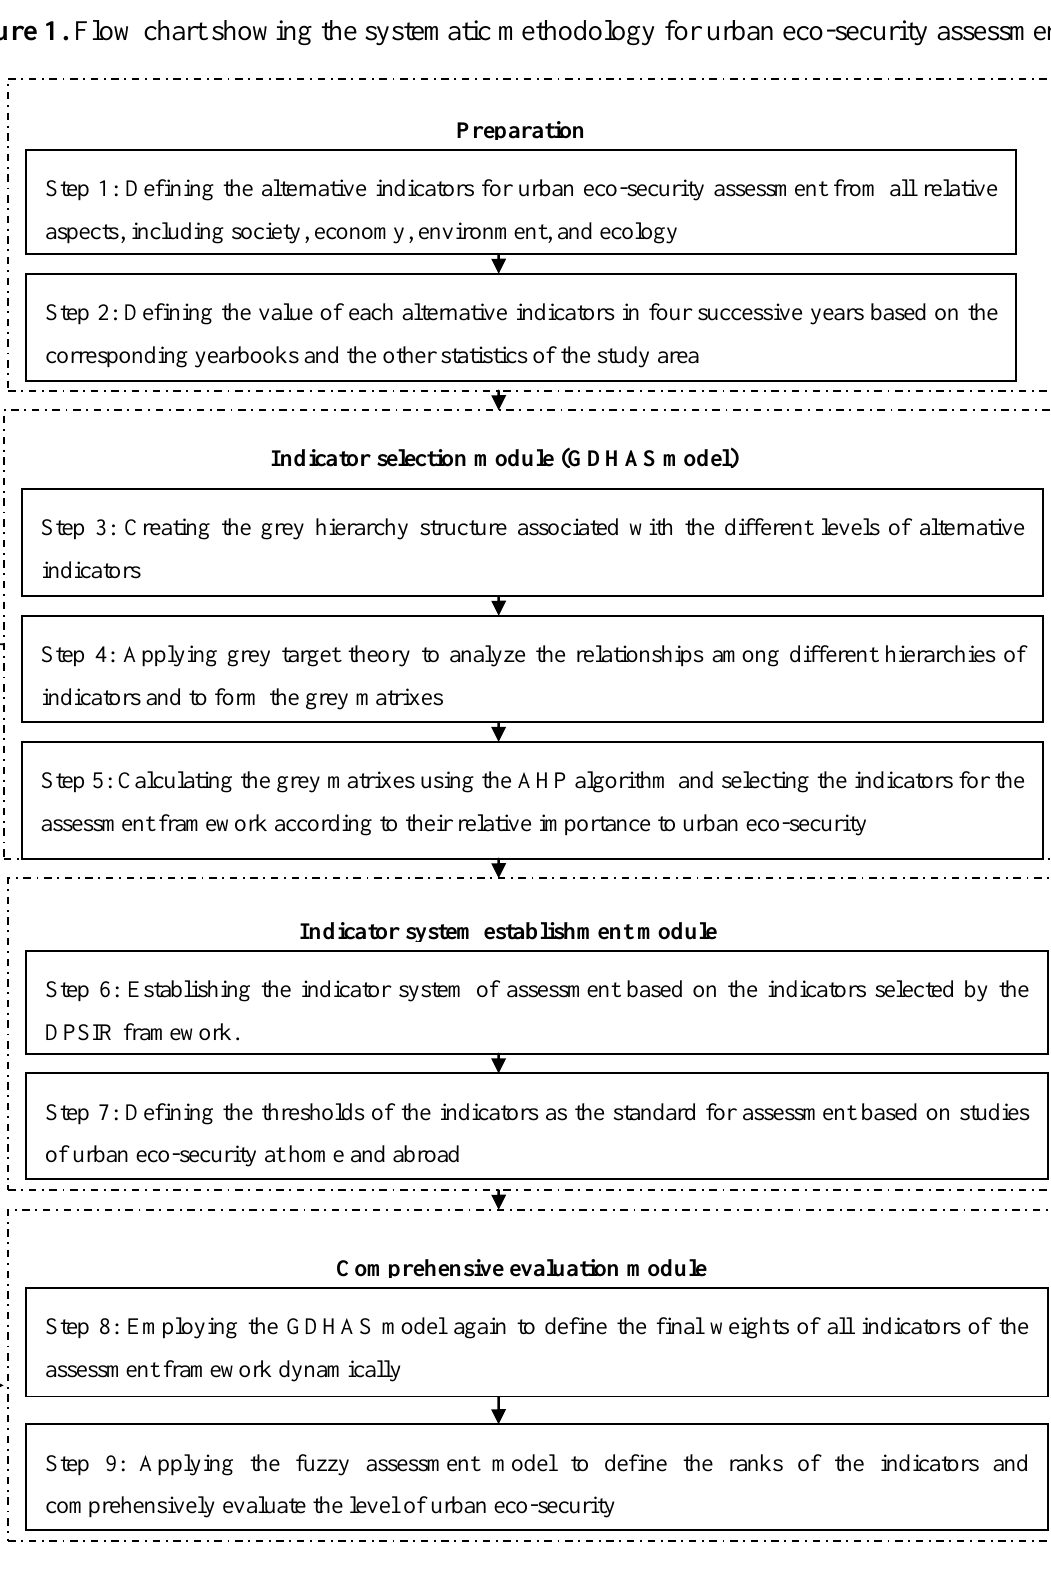
Figure 1. Flow chart showing the systematic methodology for urban eco-security